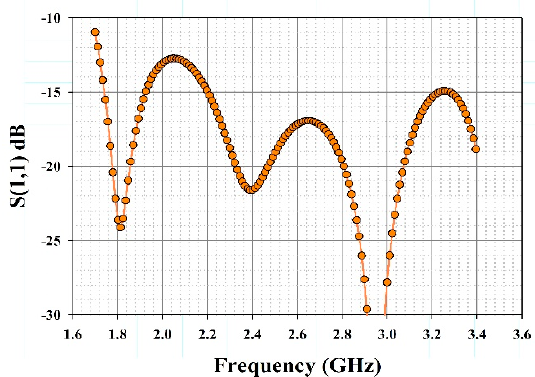
Figure 20. Input reflection coefficient for the fabricated Doherty Amplifier.